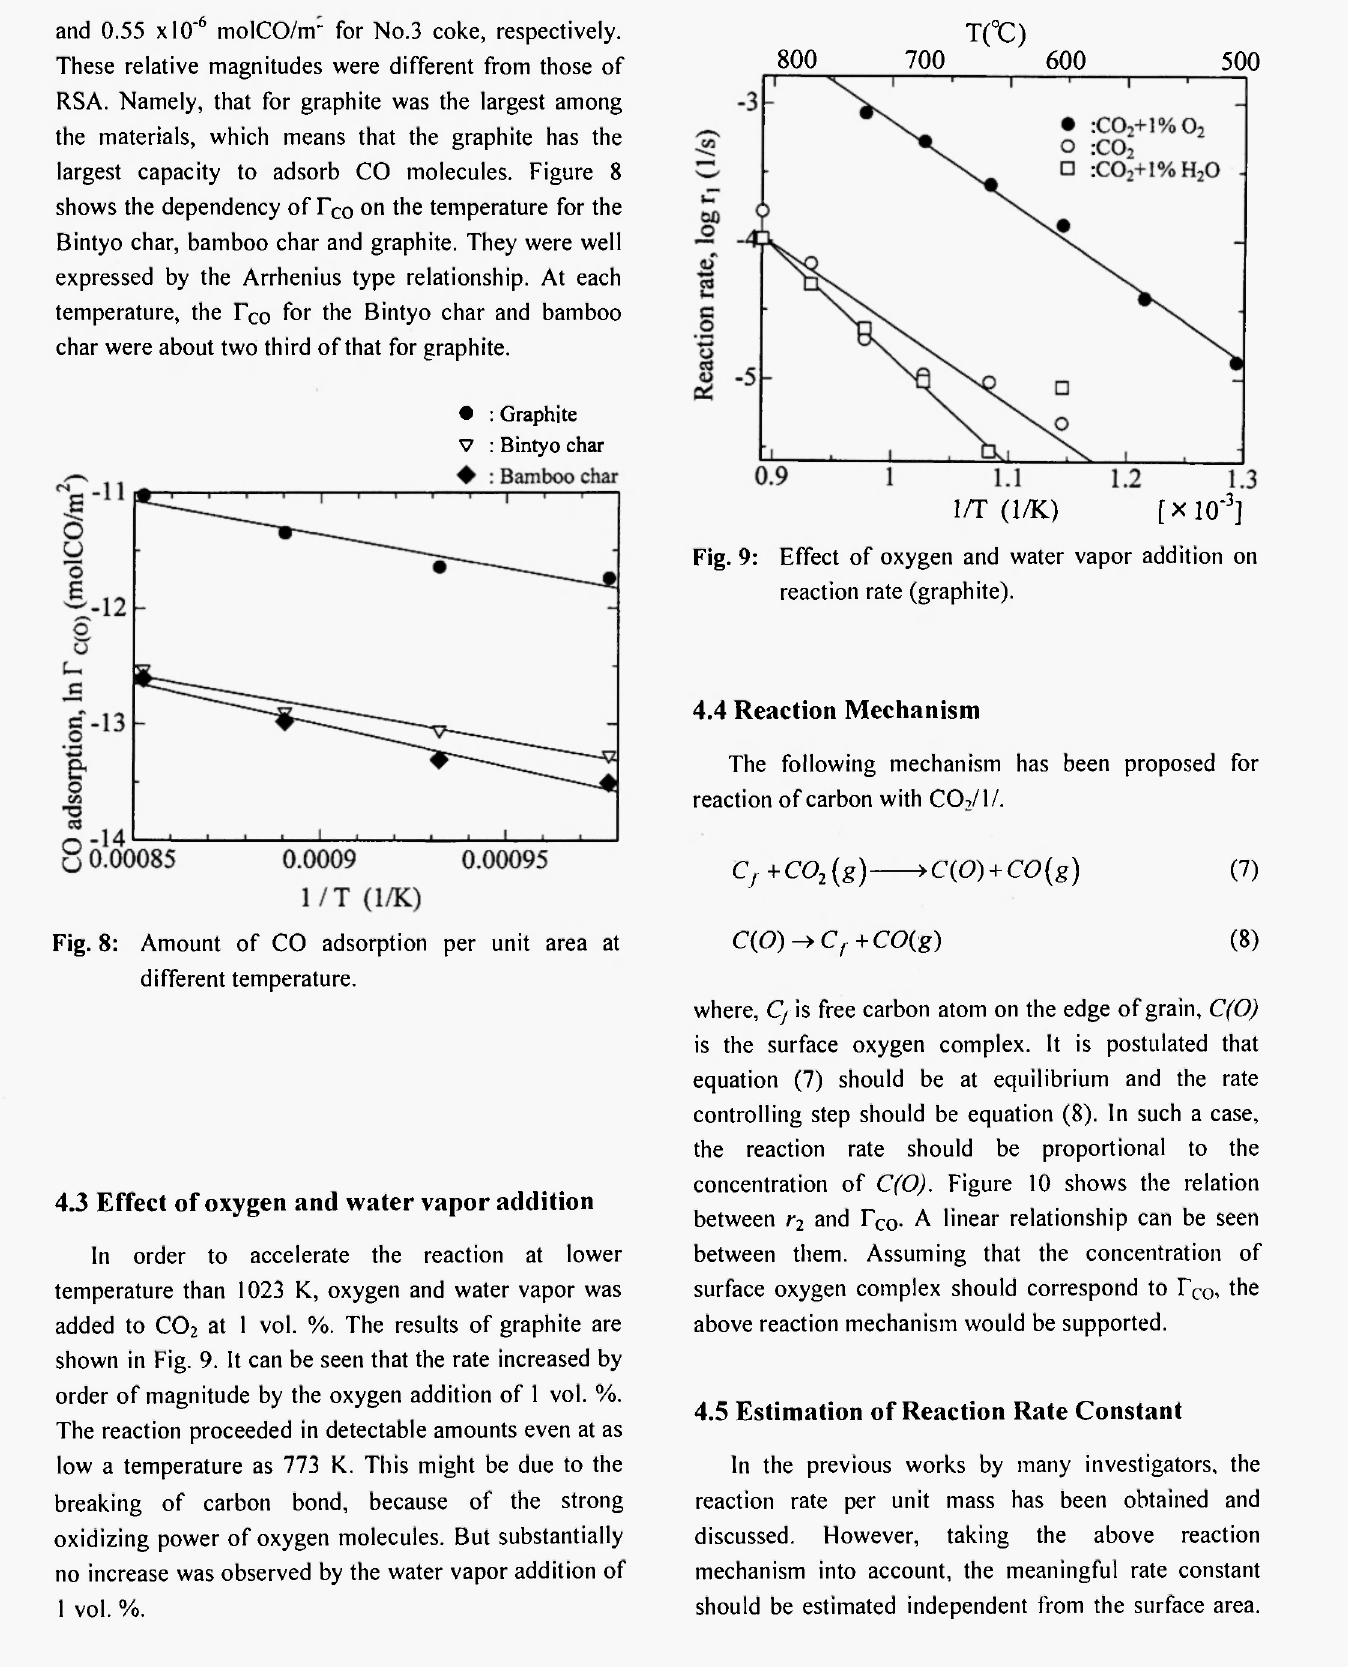
Fig. 9: Effect of oxygen and water vapor addition on reaction rate